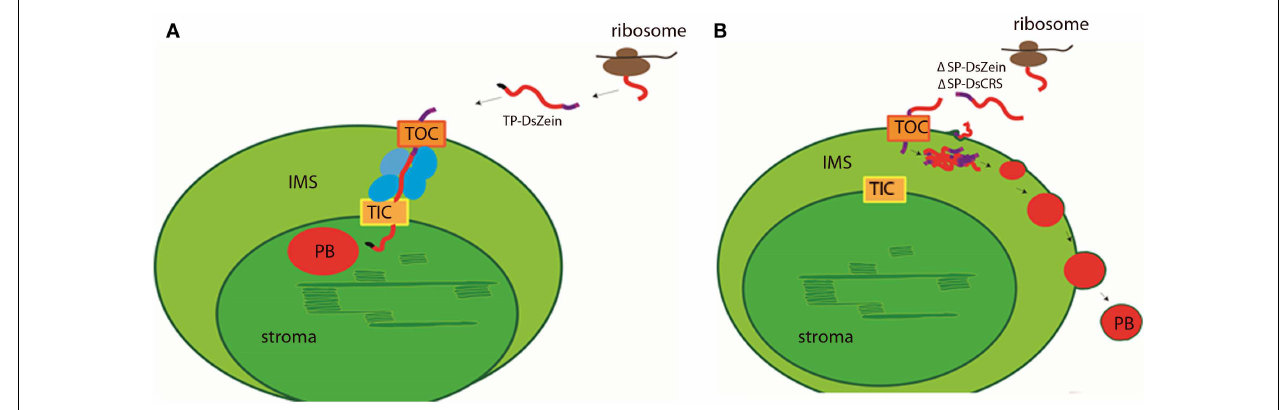
may enter the plastid via theTOC complex or a non-canonical route. After crossing the outer plastid membrane the fusion protein assembles into insoluble polymers that are no longer competent for further transport. PBs are formed in the IMS and bud off from the plastid.The DsRed sequence is shown in red, γ -zein sequences are shown in purple, ribosomes are marked in